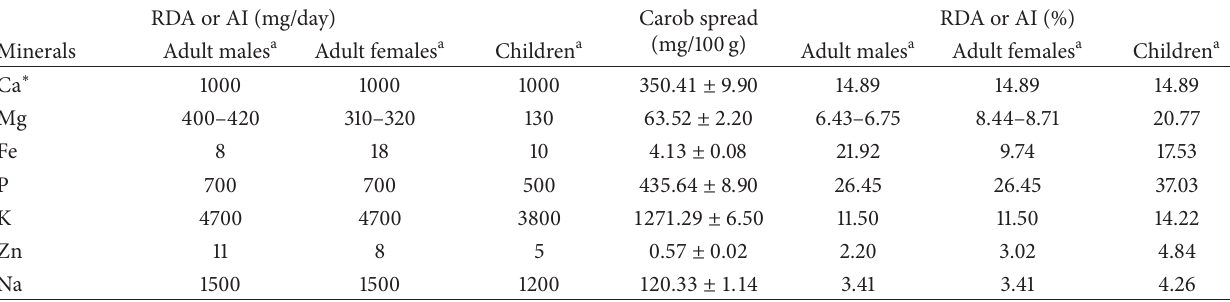
Table 5: Concentrations of several minerals in carob spreads and percentages of recommended dietary allowances or adequate intakes. RDA or AI